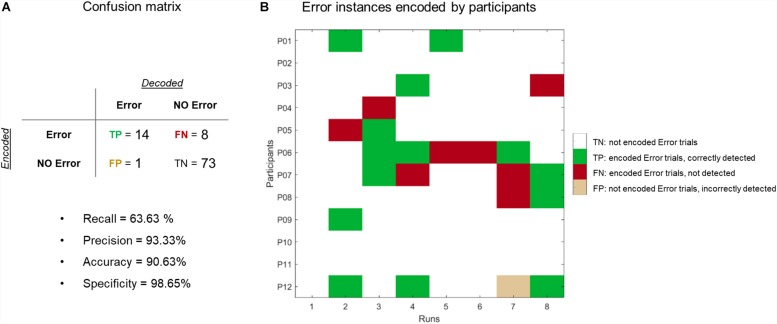
Evaluation of error-correction procedure. (A) Confusion matrix. We reached an accuracy of 90.62% (72/96 trials were correctly labeled as “Error” or “NoError”) and a recall level of 65.22% (out of 22 error trials, 8 trials were missed). (B) Summary matrix of when participants encoded the “Error” option (marked in dark gray). Green (red) cells represent trials where the “Error” option was correctly (incorrectly) detected. Beige cells indicate a false positive trial.